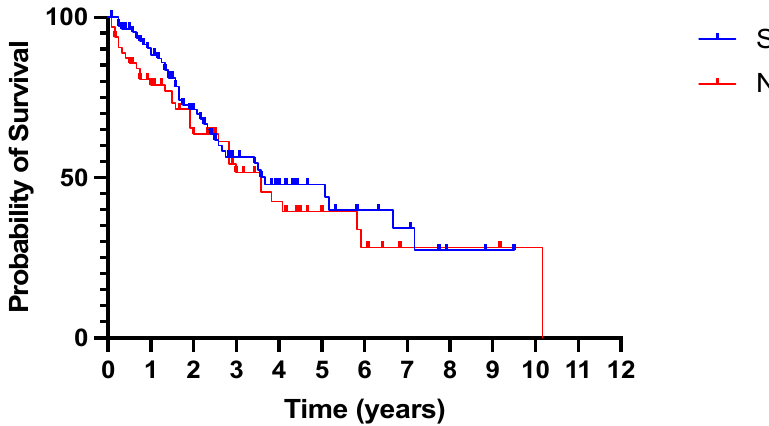
Figure 4. Overview of different treatments received in surveillance and non-surveillance groups. TACE (transarterial chemoembolisation), SABR (stereotactic ablative radiotherapy), BSC (best sup- portive care). * p < 0.05 (chi-square test).